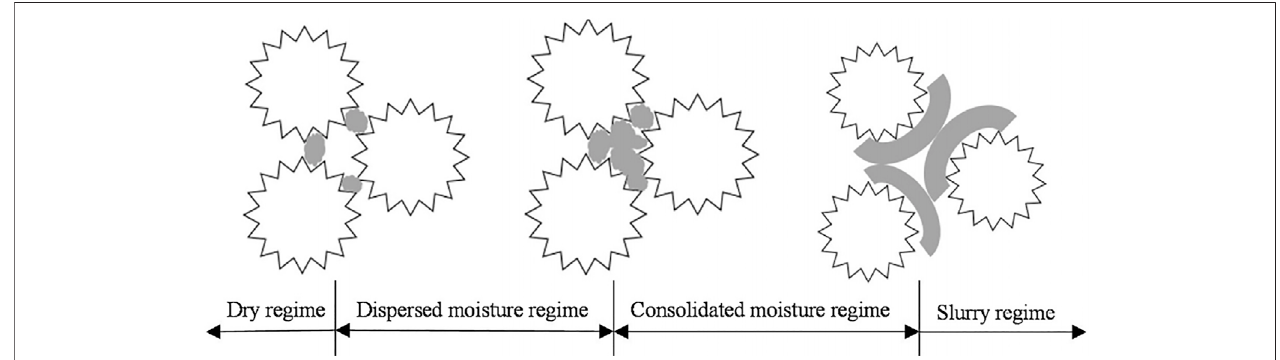
FIGURE7| Schematicofcontactingparticleswithincreasingmoisturecontent.Thewhiteshapeswithcoarseedgesrepresentparticlesandthegraydotsandlines represent water droplets. Adapted with permission from Lu et al. (2018).